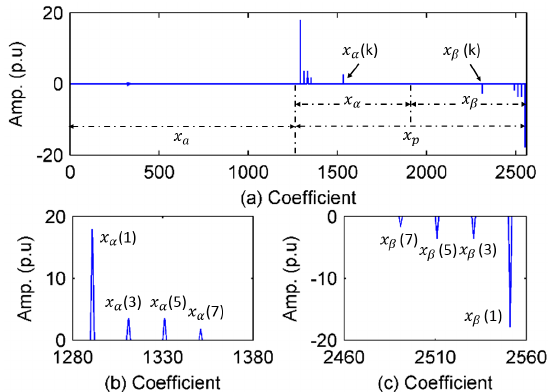
Figure 1. The schematic diagrams of x α and x β . ( a ) The position of x α and x β in mapping coefficients (MCs); ( b ) examples of (cid:1876) (cid:3080) ((cid:1863)) ; ( c ) examples of (cid:1876) (cid:3081) ((cid:1863)) . Amp.: Amplitude .